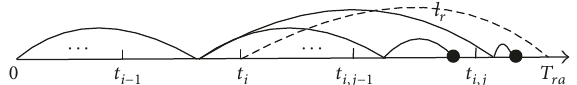
Figure 2: A delayed failure replacement with an emergency ordered spare.